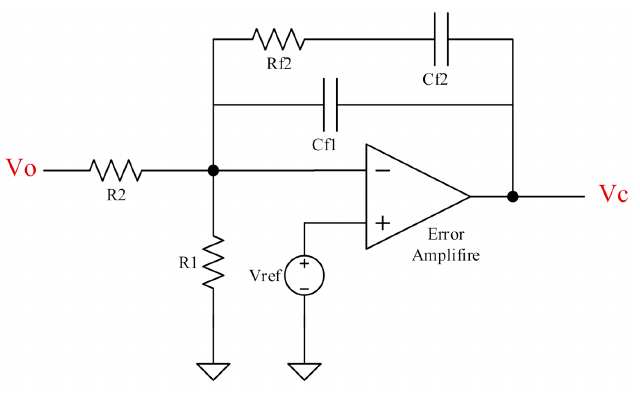
Figure 12. Type two compensation